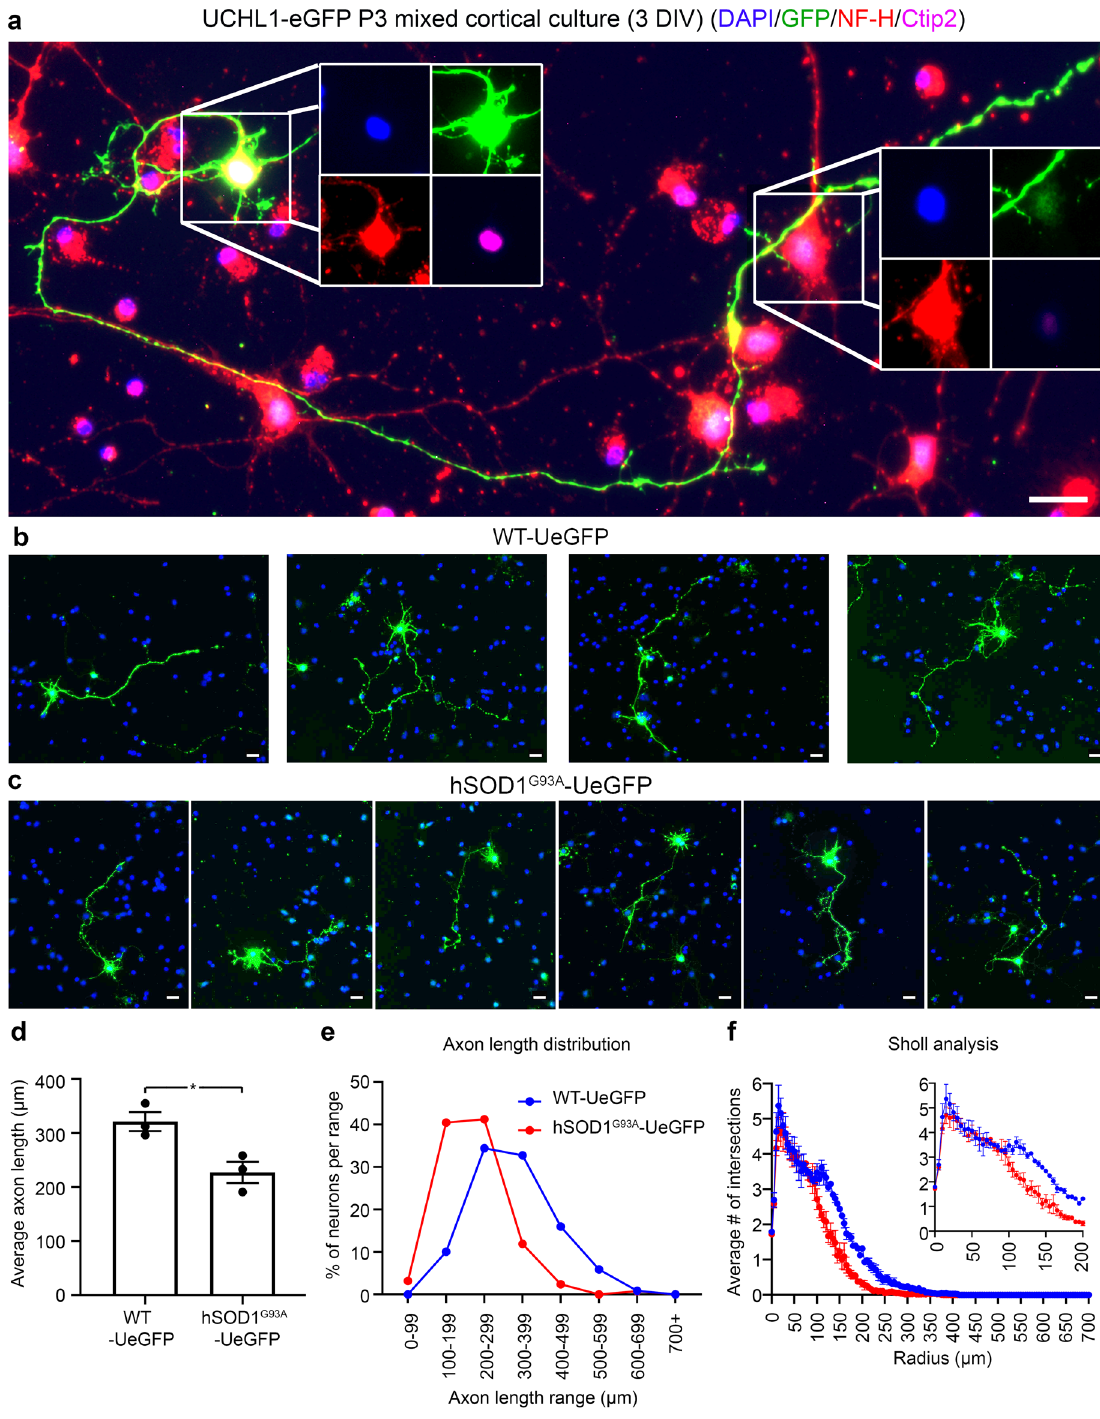
Figure 2. UMNs are distinguished from other neurons in culture, and changes in average axon length and branching/arborization offer quantitative outcome measures to investigate UMN health ( a ) UMNs retain their neuronal identity (NF-H + and Ctip2 +) and GFP expression in culture, and they can be distinguished from other neurons that are not an UMN (NF-H + , Ctip2 -). UMNs have large pyramidal cell bodies and long axons. ( b-c ) UMNs can be visualized and assessed individually in both control WT-UeGFP mice ( b ), and the hSOD1 G93A -UeGFP ALS mouse model ( c ). ( d-e ) Bar graph representation of average axon length and ( d ) and percent distribution of UMN based on average axon length in WT-UeGFP (blue) and hSOD1 G93A -UeGFP (red) mice. ( f ) Sholl analysis of healthy and diseased UMNs with 5 µm circular increments. 0–200 µm radius range is enlarged in the inset for clarification. Mean, SEM, and individual data points shown for n = 3 biological replicates. * p < 0.05, unpaired t-test with Welch’s correction. Scale bars = 20 μm, n = 3 biological